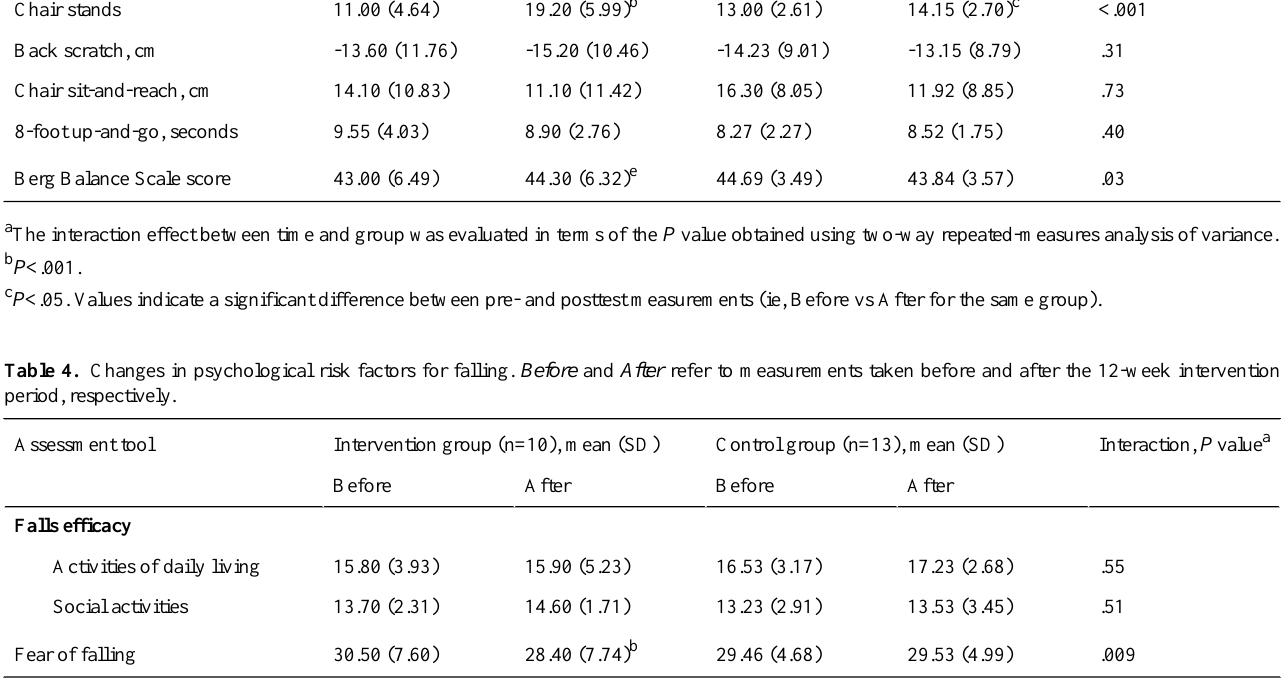
Interaction, P value a Control group (n=13), mean (SD)Intervention group (n=10), mean (SD)Test